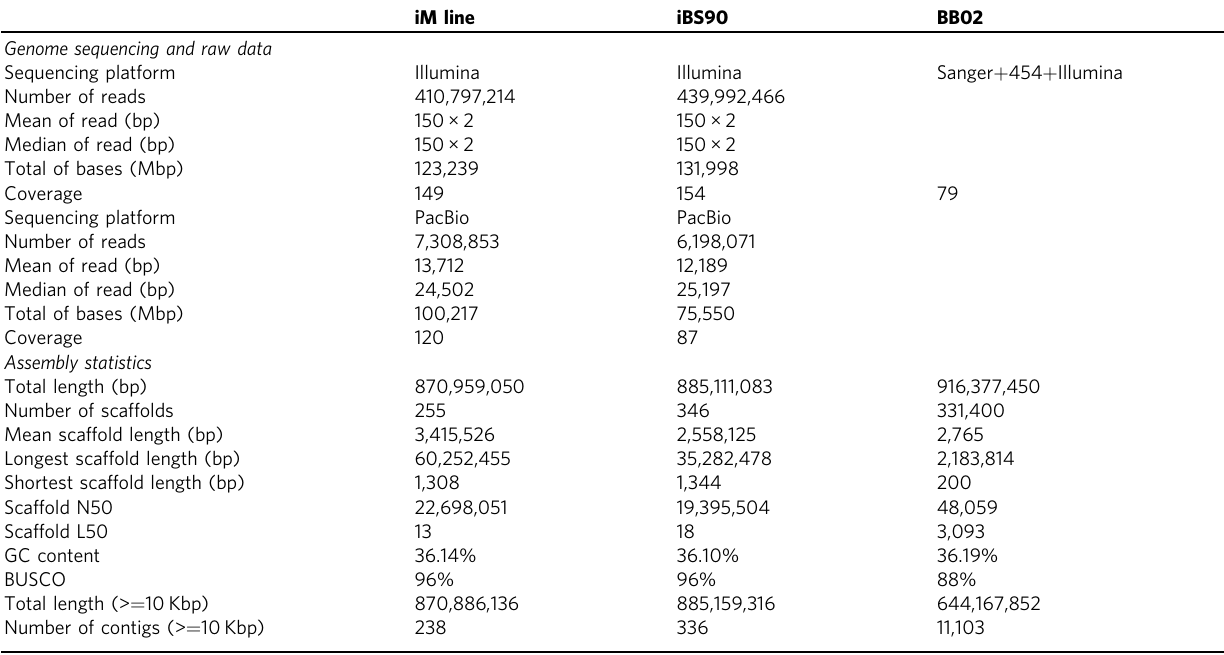
Table 1 Summary statistics of the genome assembly of iM line and iBS90 in comparison with reference genome of BB02